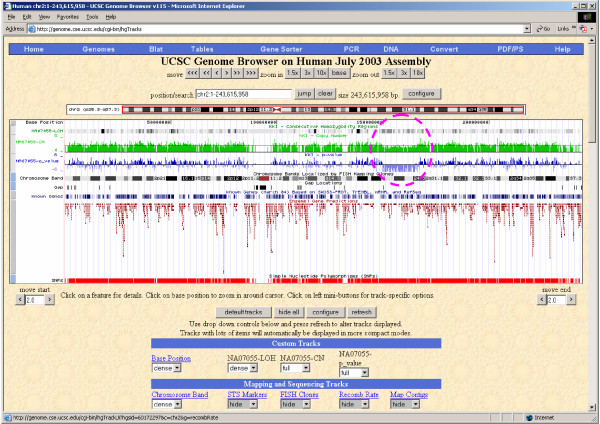
Screen capture of SNP data visualized in the UCSC Human Genome Browser. SNPscan converts a text file that has been generated by CNAT into a WIG file, which can then be visualized on the UCSC Genome Browser. For case NA07055 (shown in Fig. 2), 50 K Xba SNP data from chromosome 2 are displayed. The three custom tracks, arranged in rows, are LOH p value (color coded with more significant p values having a darker color), copy number (in green), and copy number p value (in blue). Note a region of deletion (dashed circle). The genome browser can be viewed for each chromosome at full scale or reduced to any region of interest. Additional tracks that are displayed in this example are chromosome band, gaps, known genes, Ensembl gene predictions, and SNPs. Dozens of additional tracks can be added or removed. Each WIG file that is generated can contain multiple SNP array data sets.